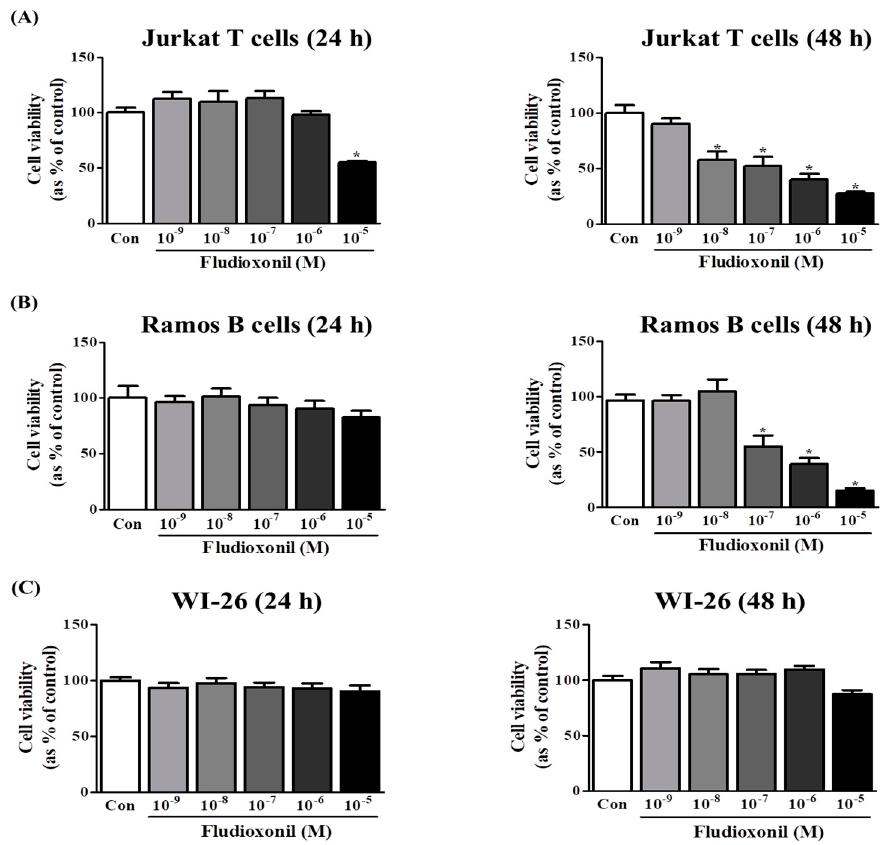
Figure 1. Viability of Jurkat T cells and Ramos B cells following the treatment of fludioxonil. Jurkat T cells, Ramos B cells and WI-26 cells (50,000 cells / well) were seeded in 96-well plates and treated with 10 − 9 –10 − 5 M fludioxonil for 24 or 48 h. Cell viability was confirmed by WST assay. DMSO was the control vehicle. ( A ) Jurkat T cells, ( B ) Ramos B cells, and ( C ) WI-26 cells. The data are shown as the means ± standard deviation (SD) of three independent experiment. * p < 0.05 as compared with the control.